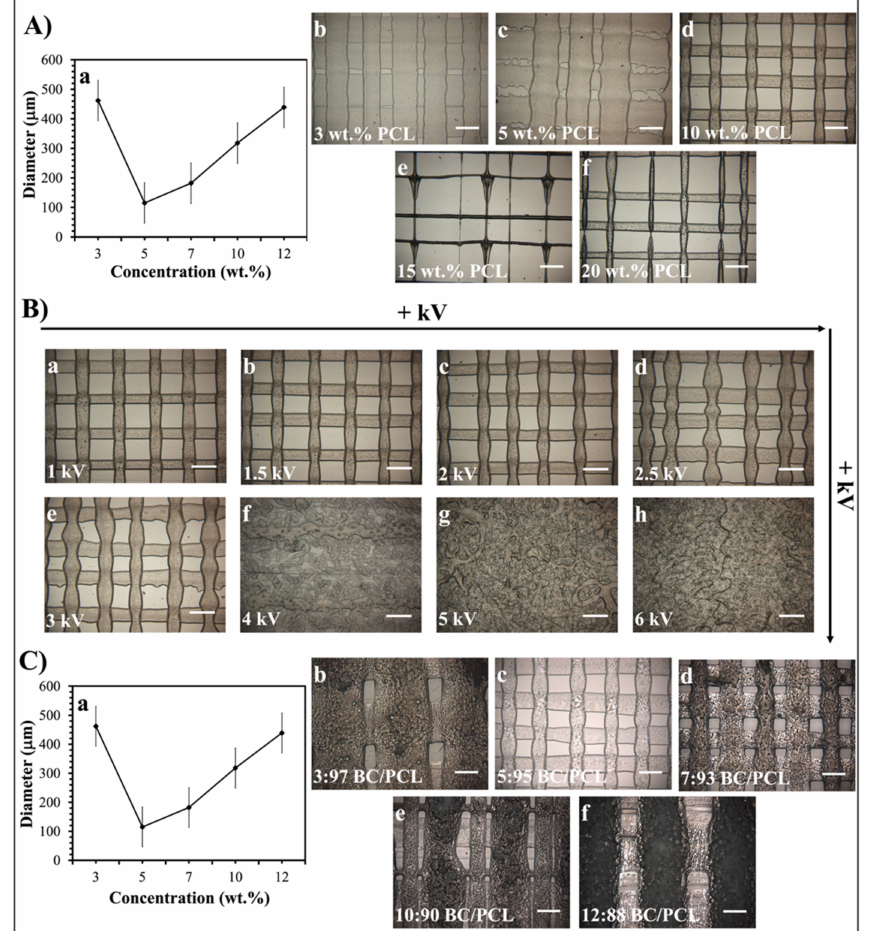
Figure 2. ( A ) EHD-3D printed fiber diameter graph (a) using different concentrations of PCL solution and optical images of the patches (b–f). ( B ) Optical images of the various voltage value (1–6 kV) applied EHD-3D printed deposited fibers of 10 wt.% PCL with different alignments and structures. ( C ) EHD-3D printed fiber diameter graph (a) using different concentrations of BC/PCL composition and optic images of the samples (b–f). (All scale bars indicate 100 µ